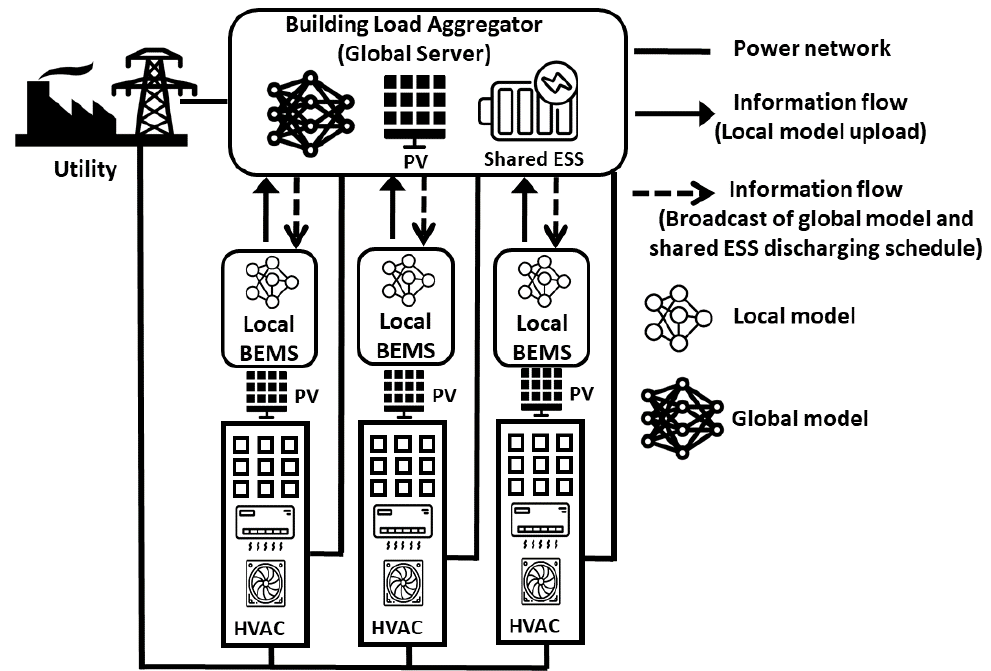
Figure 1. System architecture of a federated reinforcement learning (FRL)-based building energy management system (BEMS) with a shared energy storage system